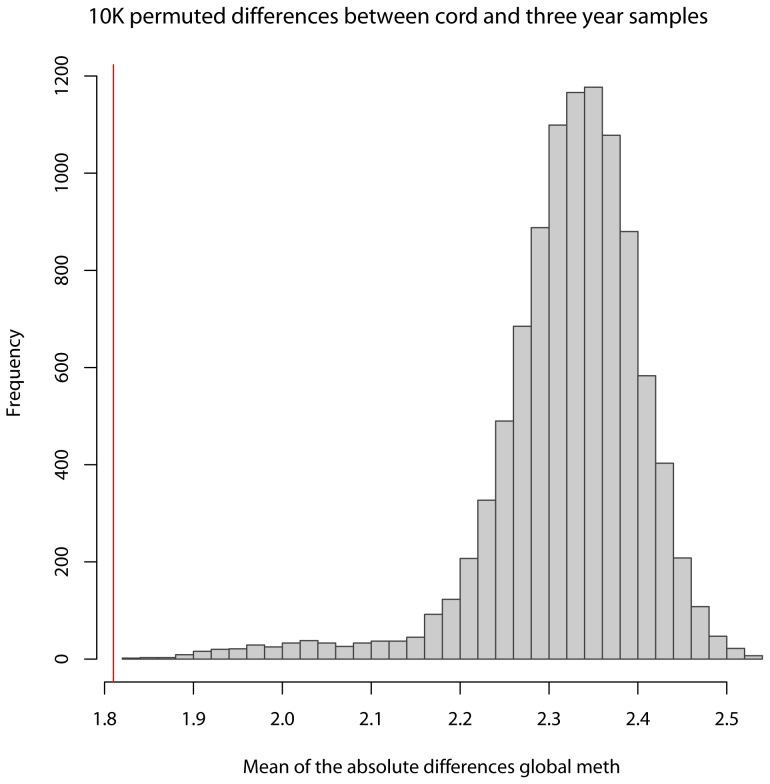
Permutation analysis.Gray histogram depicts the distribution of absolute mean differences in DNA methylation from the 10,000 random pairings of cord and three-year samples. The solid red bar indicates the actual mean absolute difference in DNA methylation from birth to age three in the same individual.